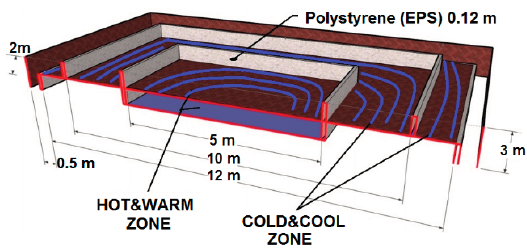
Figure 4. Cross section of the ground heat exchanger.